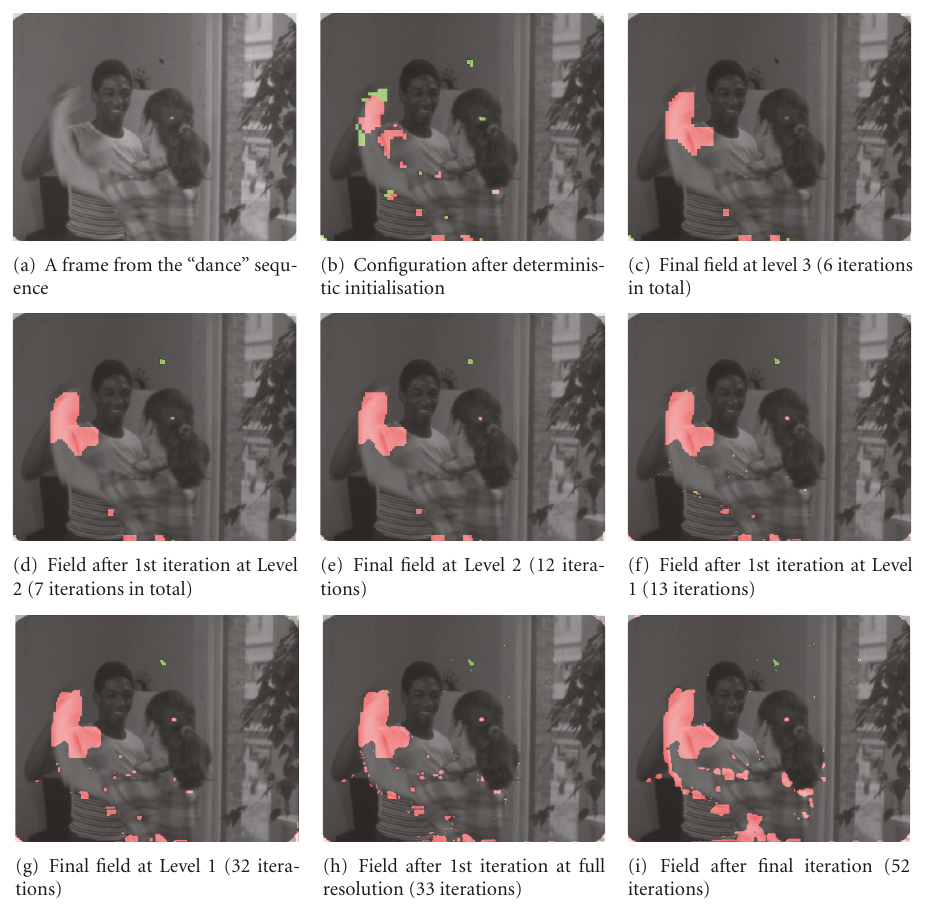
Figure 9: This figure shows intermediate values of the label field (PM—Red, Blotches—Green) at various iterations of the ICM optimisation process for a frame from the “dance” sequence. The standard parameter set is used (Section 5.2) and the value of δ t is 7. Level 0 corresponds to the full resolution; the resolution at level 1 is 360 × 288 and so on. At the coarsest resolution (Level 3) the resolution is 90 × 72 pixels.